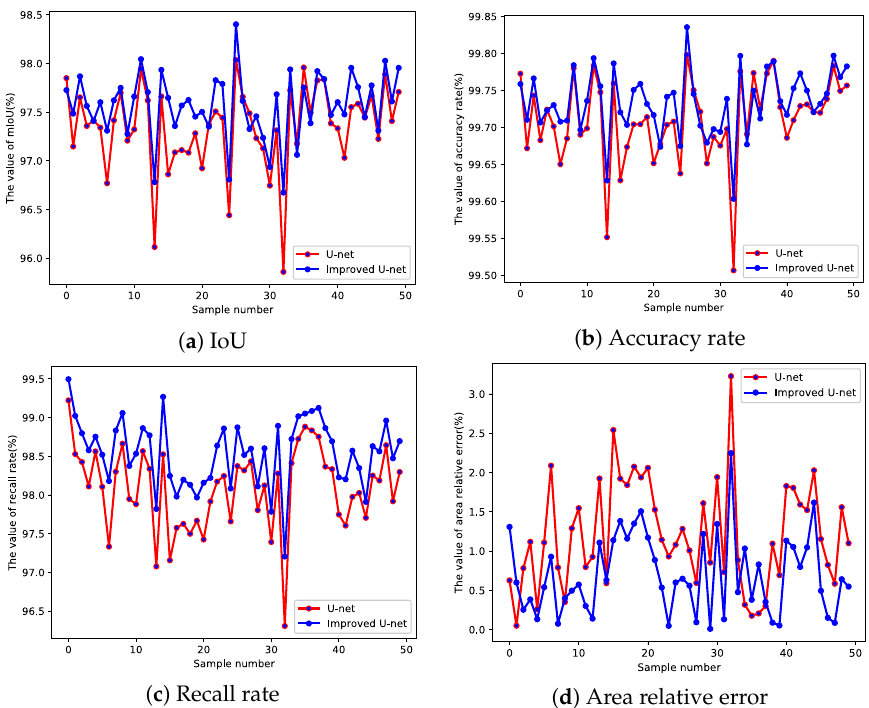
Figure 16. Comparison of performance on four metrics when the fish body is